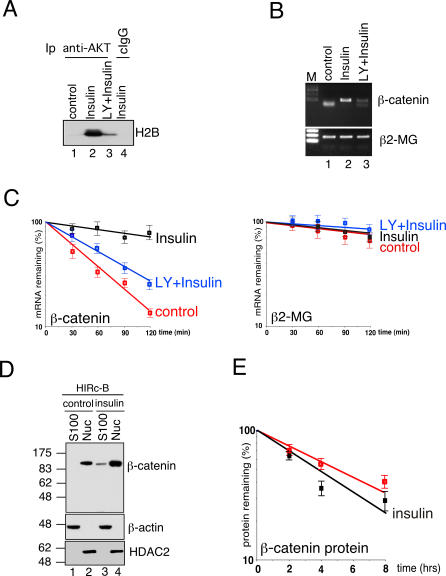
Insulin Stabilizes β-Catenin mRNA and Increases Its Expression(A) HIRc-B cells were treated for 1 h with DMSO (control), insulin (10−6 M) plus DMSO, or LY (25 μM for 16 h) plus insulin. Total extracts were immunoprecipitated with either anti-AKT antibody or control IgG (cIgG). Pellets were incubated (20 min at 30 °C) with histone 2B (H2B) in kinase buffer in the presence of [γ-32P]ATP. Labeled proteins were separated by SDS-PAGE and detected by autoradiography.(B) Expression of β-catenin and β2-MG, monitored by RT-PCR, in control HIRc-B cells and in HIRc-B treated with either insulin or LY plus insulin.(C) Quantitative RT-PCR analysis of both β-catenin and β2-MG transcripts in control HIRc-B cells, in HIRc-B treated with either insulin or LY plus insulin. Total RNA was isolated at the indicated times after the addition of actinomycin D. The values shown are averages (±SEM) of three independent experiments performed in duplicate.(D) Immunoblot analysis of either S100 or nuclear extracts from either control- or insulin-treated HIRc-B cells with anti–β-catenin, β-actin, and HDAC2 antibodies. The amount of each band was quantitated by densitometry and insulin was found to increase β-catenin expression by 3.2- and 2.1-fold over the control in S100 and nuclear extracts, respectively.(E) HIRc-B cells were maintained for 16 h in DMEM containing 0.1% FCS; then either PBS (control) or insulin (10−6 M) was added for 1 h. Cultures were then treated with cycloheximide (50 μg/ml) for the indicated times. Total cell extracts were prepared, and the levels of β-catenin quantitated by immunoblotting and densitometric scanning. Results are the average (±SEM) of three experiments. β-Actin immunoblotting was used to verify the equal protein loading.